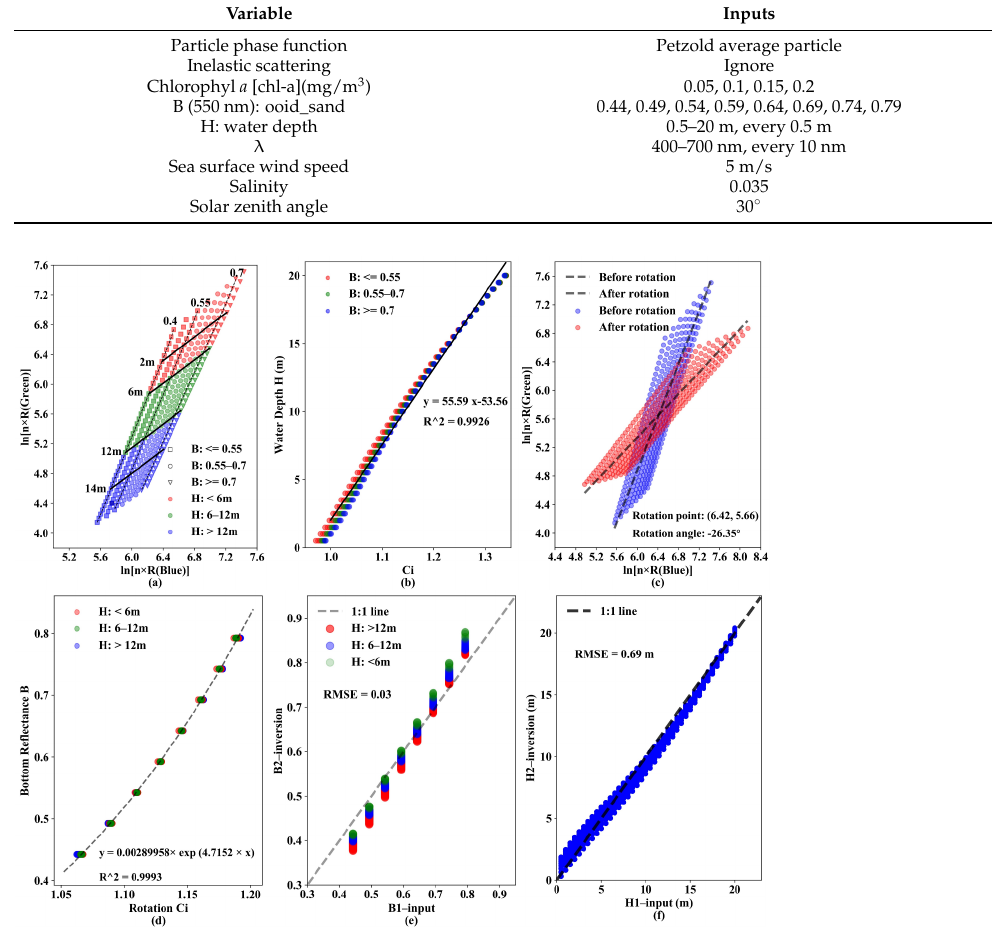
Figure A1. The Hydrolight simulation result at 0.05 mg/m 3 of Chl-a. ( a ) Hydrolight simulation reflectance of blue–green bands. Different colors represent different water depths, and different shapes represent different bottom reflectance. Black straight lines represent the water depth con- tours, and black dotted lines represent the bottom reflectance contours. ( b ) Fitting curve of (cid:1829) (cid:3036) and the corresponding water depth, H . ( c ) Scattered points in ( a ) before and after a clockwise rotation of 26.35° (–26.35°) to (cid:1829) (cid:3036)(cid:4593) , where the best correlation with bottom reflectance occurs. ( d ) Exponential fitting curve of (cid:1829) (cid:3036)(cid:4593) and bottom reflectance, B . ( e ) Fitting curve of the inversion result B2 and Hy-